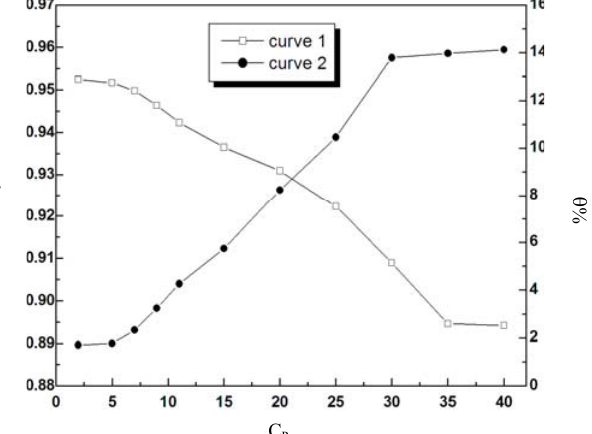
Figure 2. Dependence of the relative mass (curve 1) and binding degree θ (curve 2) of the P(MAA-co-MMA) / PVP complexes on the initial concentration of